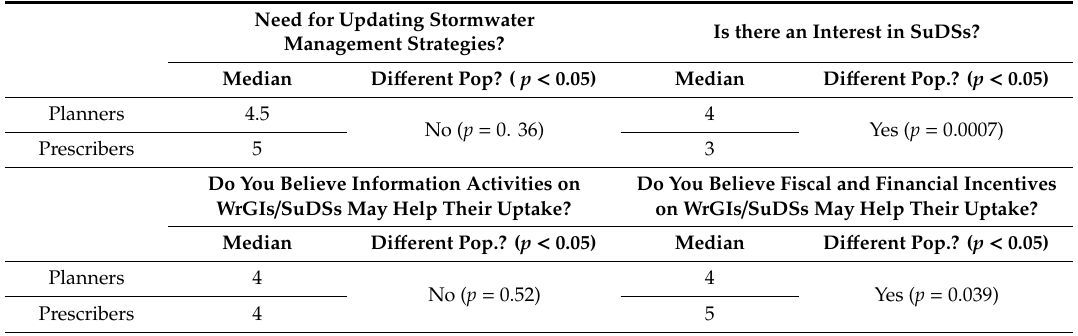
Table 4. Results of the comparisons of questions with an ordered scale from 1 to 5 between Planners and Prescribers with a Mann–Whitney U